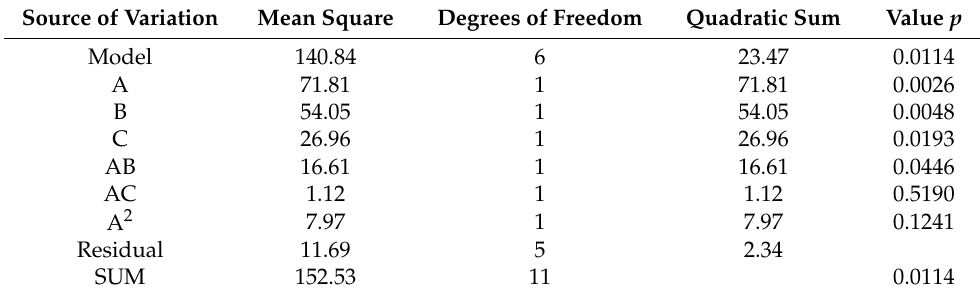
Table 7. Variance of 7-day curing cementitious material compressive strength model.